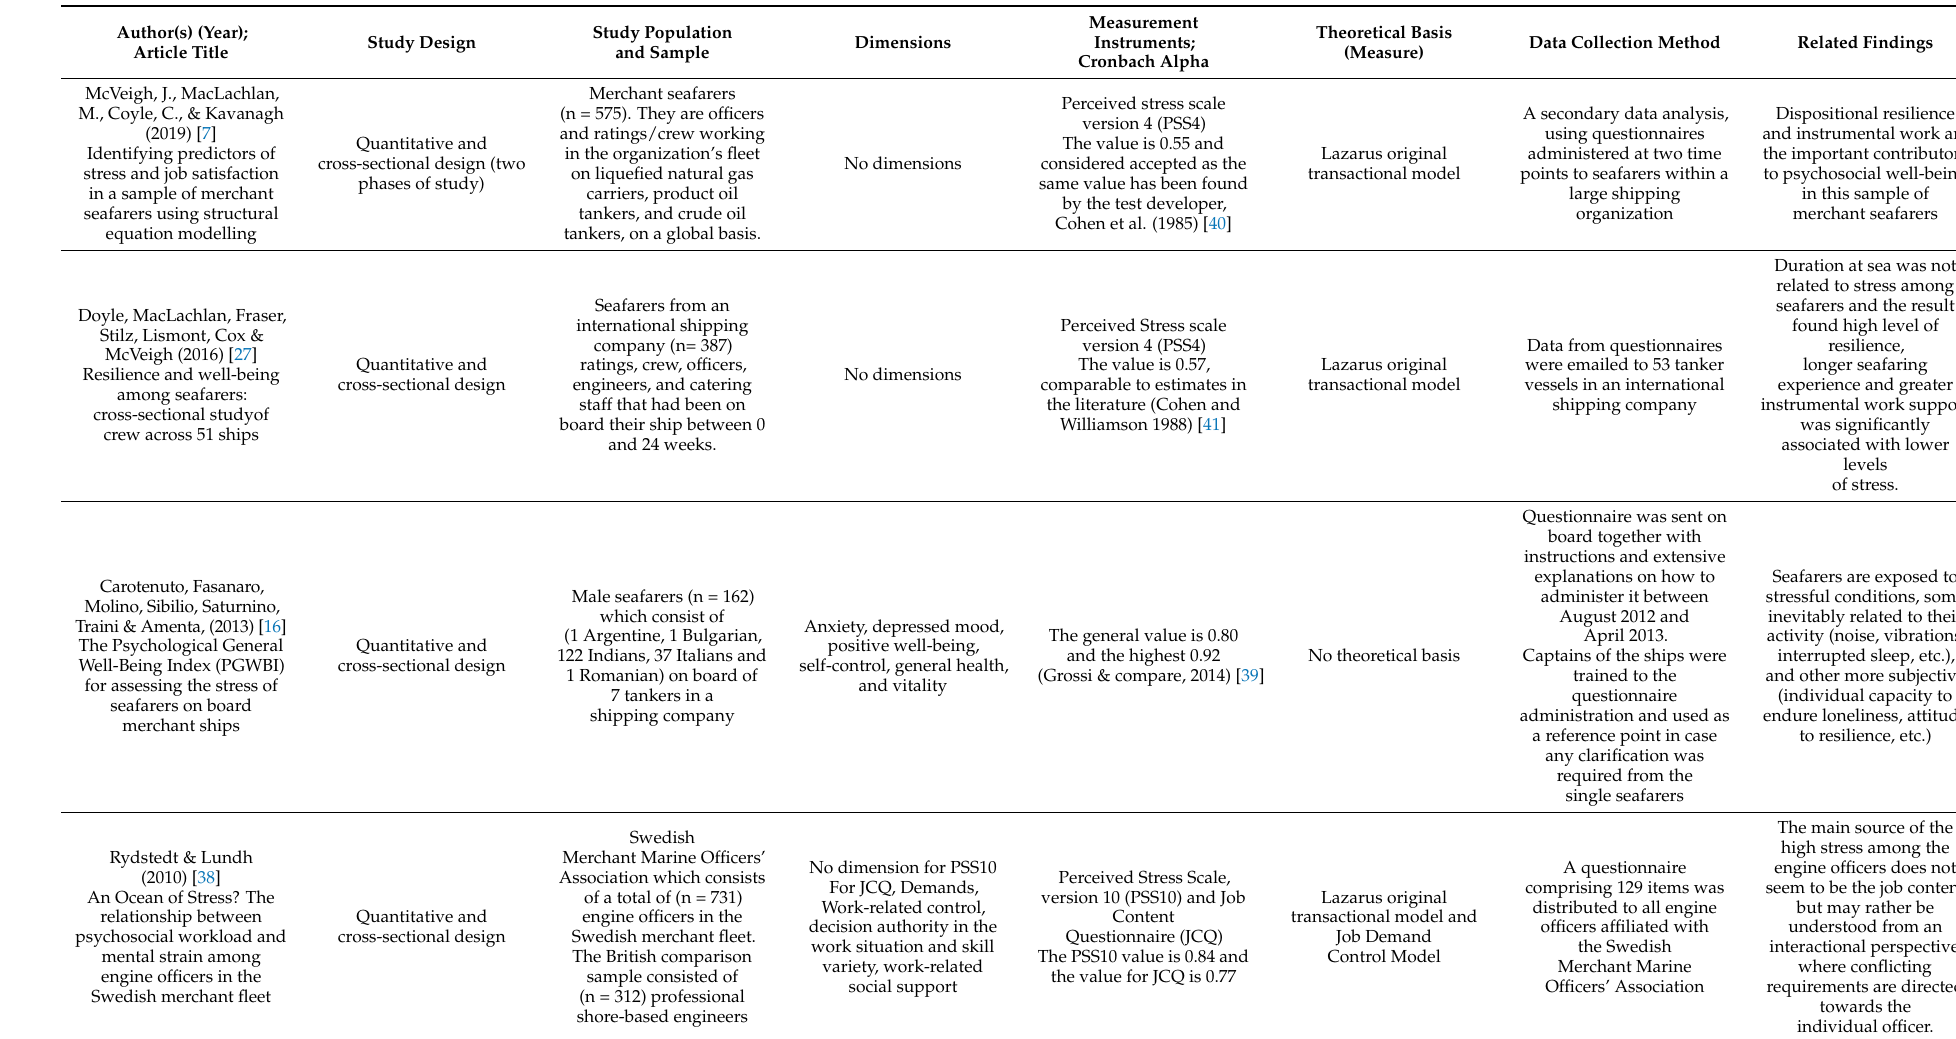
Table 3. Summary of reviewed literature (work-related stress among